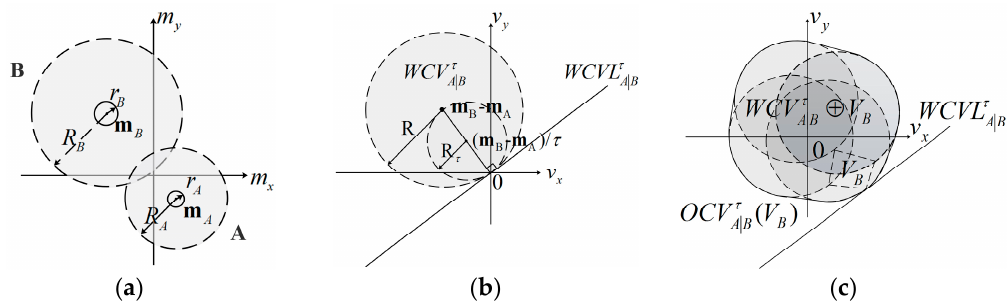
( c ) WCV . ( a ) . ( a ) Display of AB A | B and weak coverage velocity WCVL and weak A | B AB ⊕ V B owing to the fluctuation of UAV A | B WCV V owing to the BAB